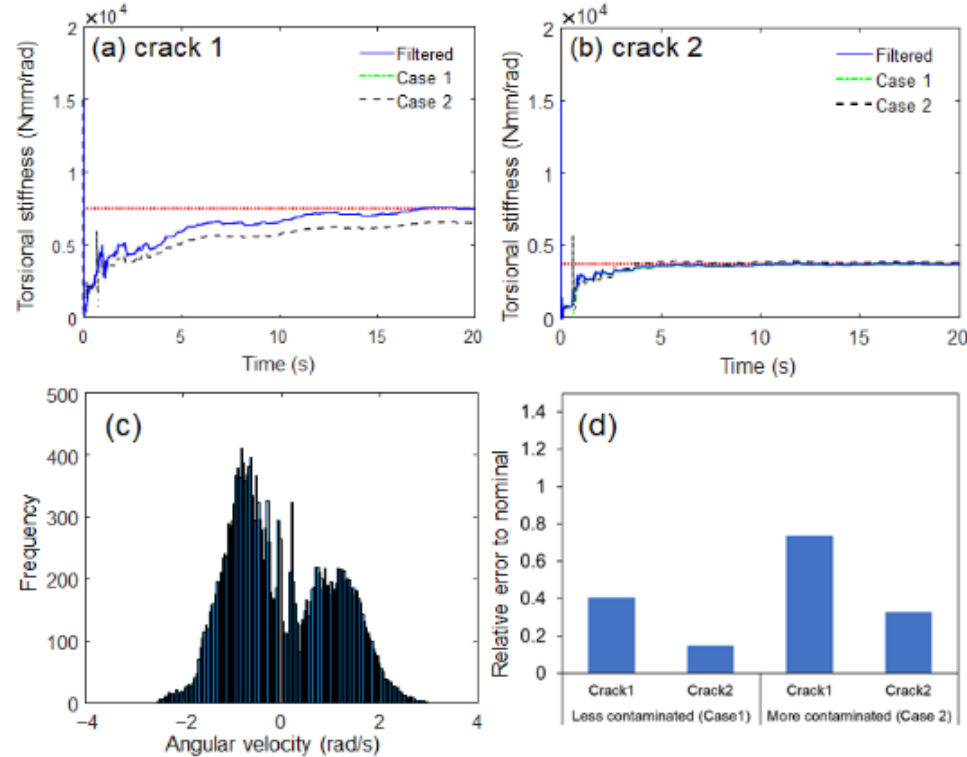
Figure 13. Estimated torsional stiffness responses under electrical sensor noise uncertainty: ( a ) crack depth 5 mm, ( b ) crack depth 11 mm, ( c ) probability density distribution of sensor noise extract from original sensor signal, ( d ) relative error to nominal.